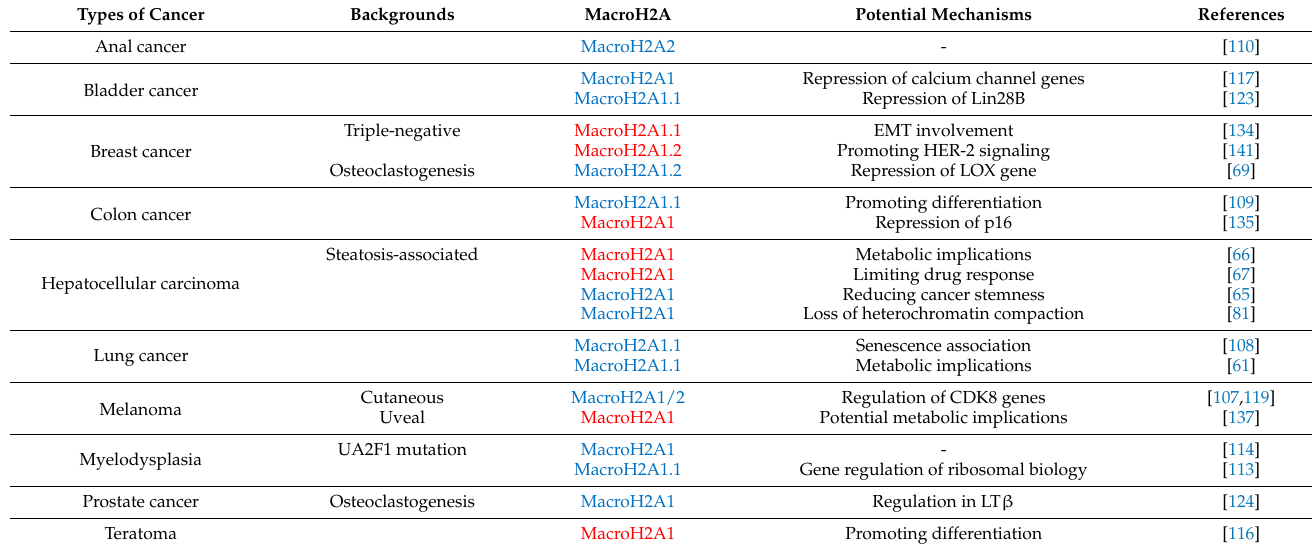
Table 2. Role of macroH2A in different